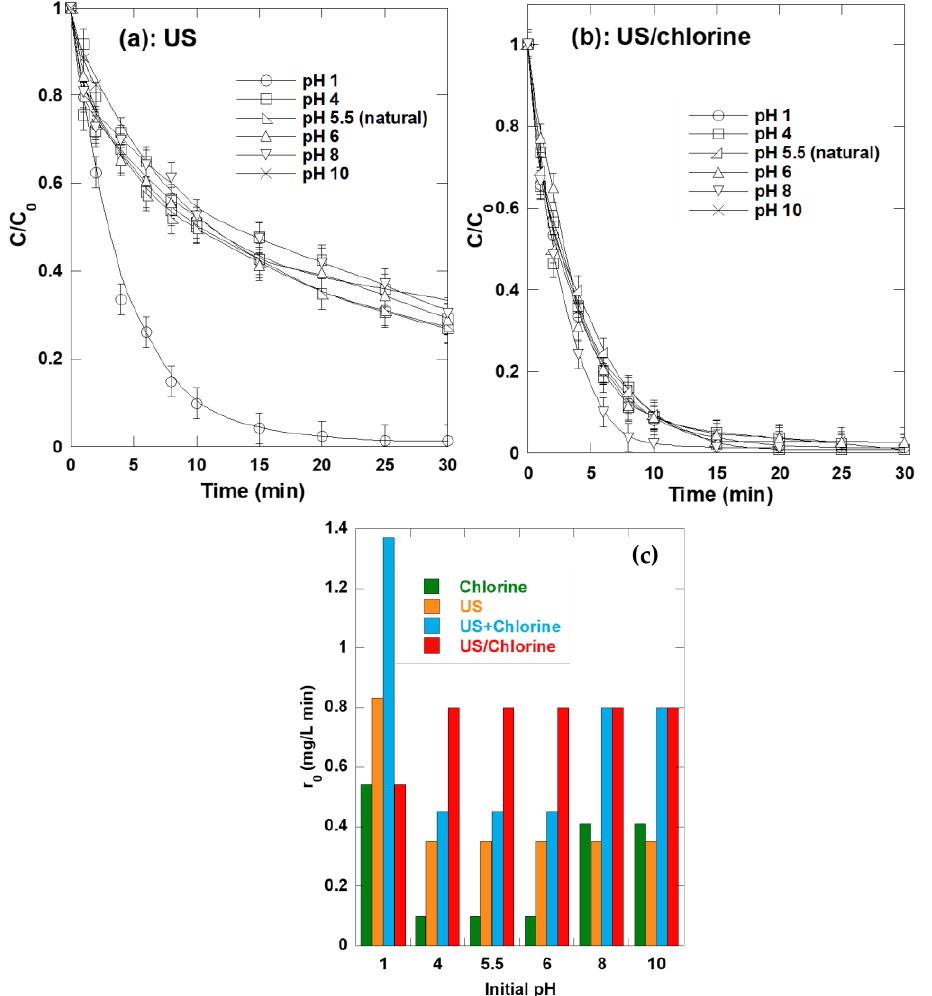
Figure 5. Effect of initial solution pH on the performance of US ( a ) and US/chlorine ( b ) processes toward the removal kinetics of ARAC (conditions: C 0 = 5 mg · L − 1 (10 µ M), [chlorine] 0 = 250 µ M, V = 150 mL, pH 1–10, temperature: 25 ± 1 ◦ C, frequency: 600 kHz, power: 120 W) and variation in ARAC initial removal rate (r 0 ) with respect to initial solution pH for chlorination alone, US alone and US/chlorine combination ( c ) (the sum of the two processes separately, US + chlorine, was added for comparison with the combined process).